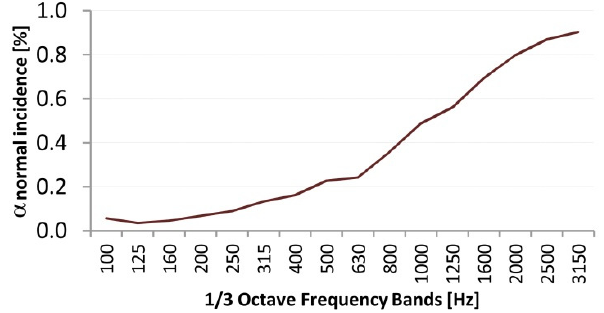
Figure 3. Normal incidence sound absorption coefficient ( α ) of the material (expanded melamine layer) used in the shading device.